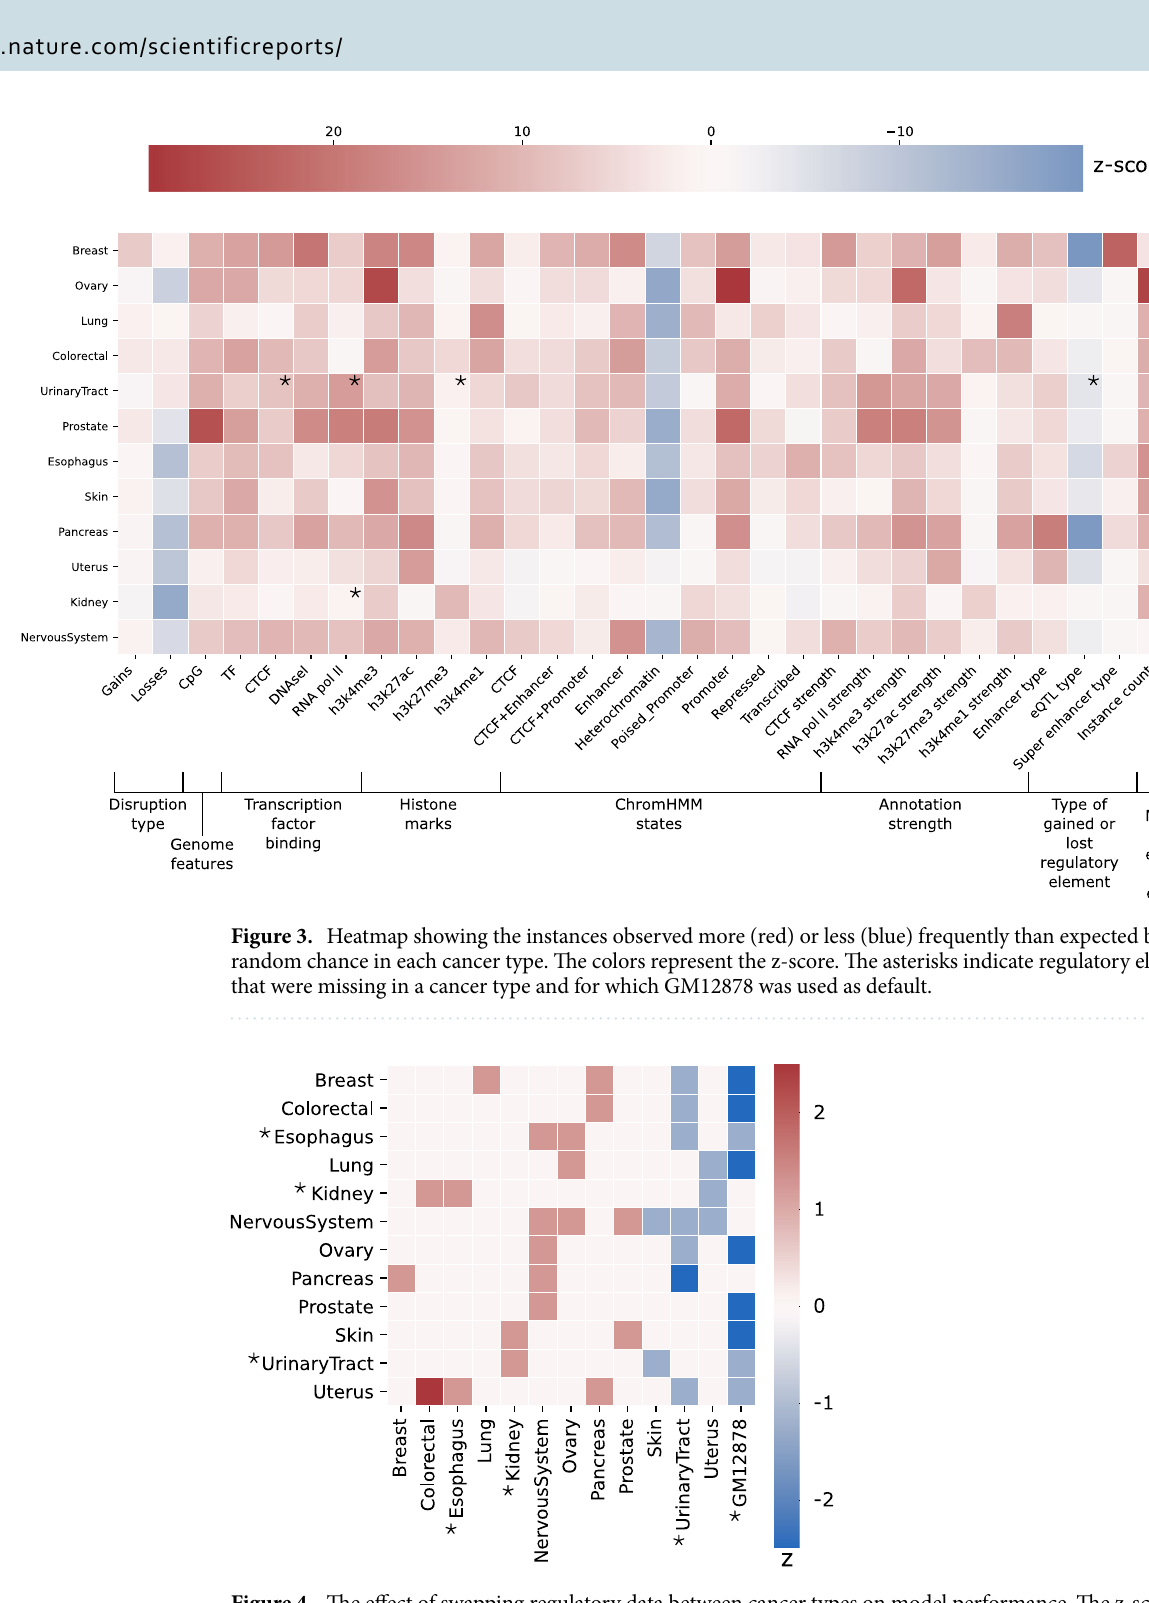
Figure 4. The effect of swapping regulatory data between cancer types on model performance. The z-score is computed by comparing the total AUC difference in a swap across all SV types to the mean of performance differences from the original run to all other swaps, divided by the standard deviation of these differences. Higher z-scores thus mean that the performance is better with data from that tissue type relative to all other tested tissue types in the swap. For example, out of all swaps made, nervous system relatively performs best with data from nervous system, ovary and prostate, while the performance is worst with data from skin, urinary tract and uterus. The asterisks indicate cancer types with some missing data for which GM12878 was